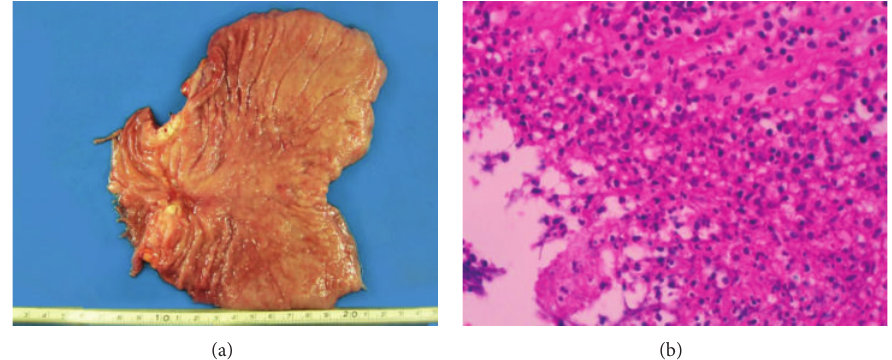
Figure 5: The appearance resected specimen. (a)The grossappearance showed an ulcerative lesion 3 cm in diameter at theantrum ofstomach. (b) Histological examination of the specimen revealed no cancer cells in the primary lesion or lymph nodes. Marked lymphocytic infiltration and fibrosis were seen in the ulcerative